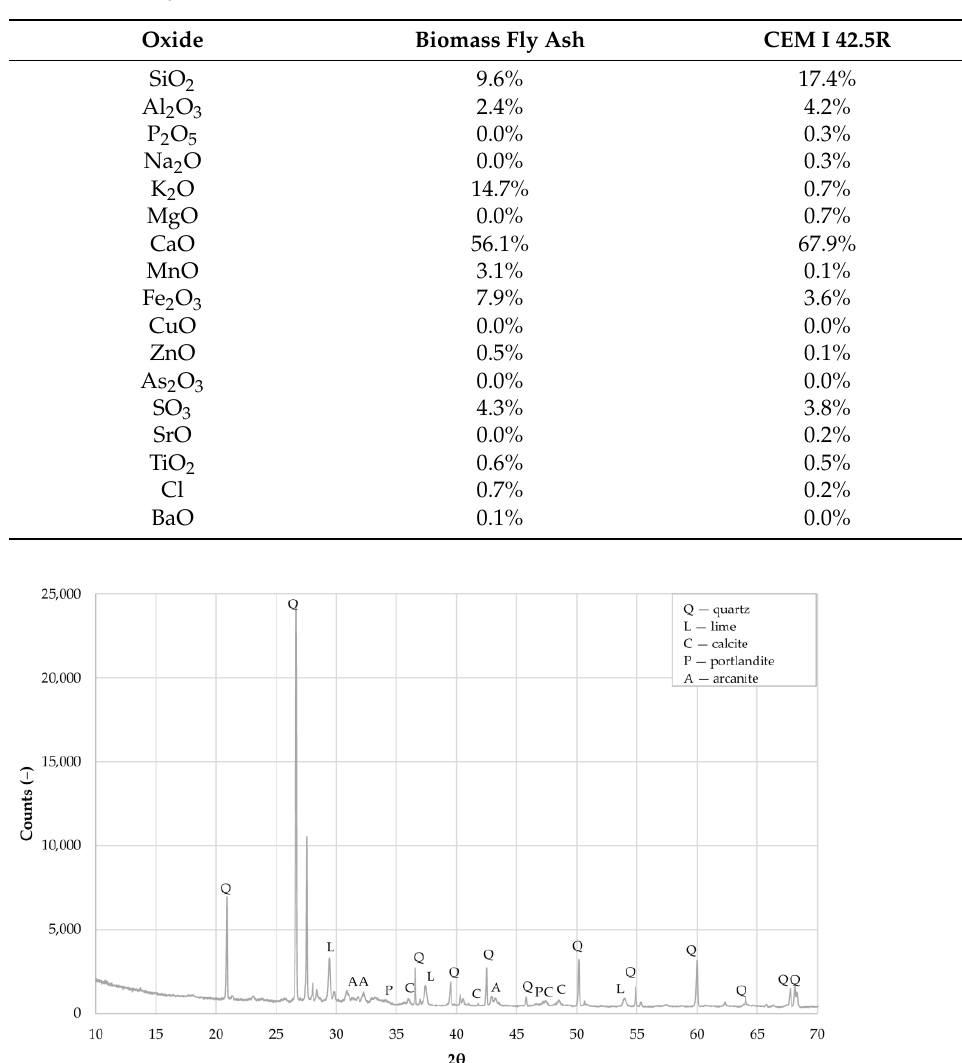
Table 1. Chemical oxide composition of biomass fly ash before activation and CEM I 42.5 R cement used in the study.